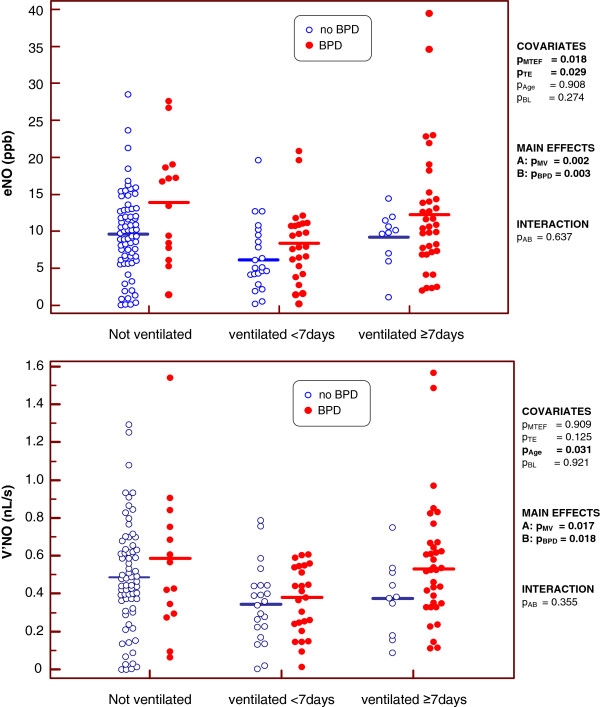
Effect of BPD and the duration of mechanical ventilation on the exhaled NO (top) and the NO production (bottom). The p-values show the extent of statistical significance of the covariates mean tidal expiratory flow (pMTEF), expiratory time (pTE), age (pAge) and body length (pBL); those of the main effects by mechanical ventilation (pMV) and BPD (pBPD); and that of the interaction (pAB) of both factors. Statistically significant values are shown in bold.